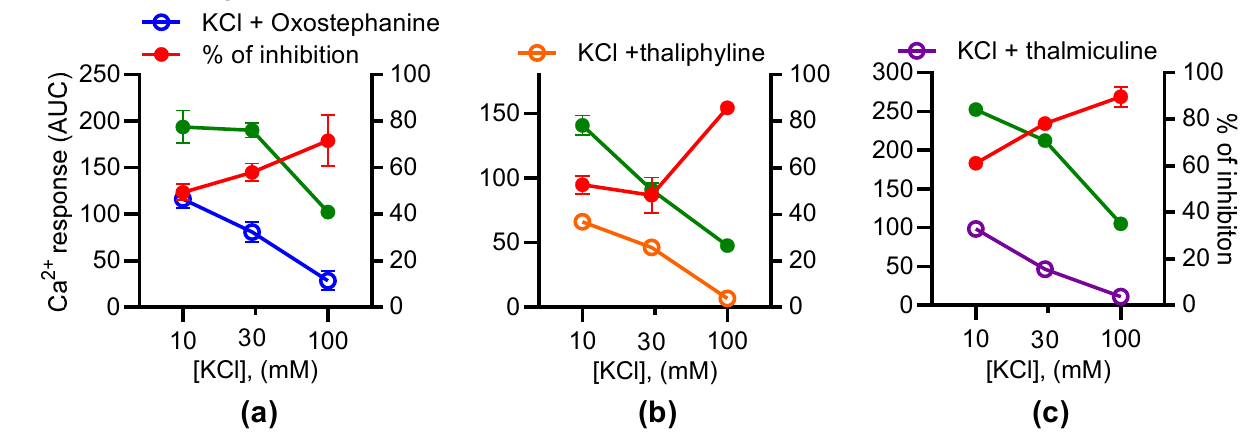
Figure 7. The inhibitory effects of oxostephanine, thaliphylline, and thalmiculine versus the KCl concentrations. The effects of 10 µM of oxostephanine ( a ), thaliphylline ( b ), and thalmiculine ( c ) were evaluated on Ca 2+ responses induced by increasing concentrations of KCl (10, 30, and 100 mM). Left y axis: AUC were determined from kinetics of the Fura-2 emission fluorescence ratio. Right y axis: the inhibition was calculated as a ratio of AUC of kinetic traces in the presence and absence of IAs in %. Data are mean ± SEM ( n = 3).